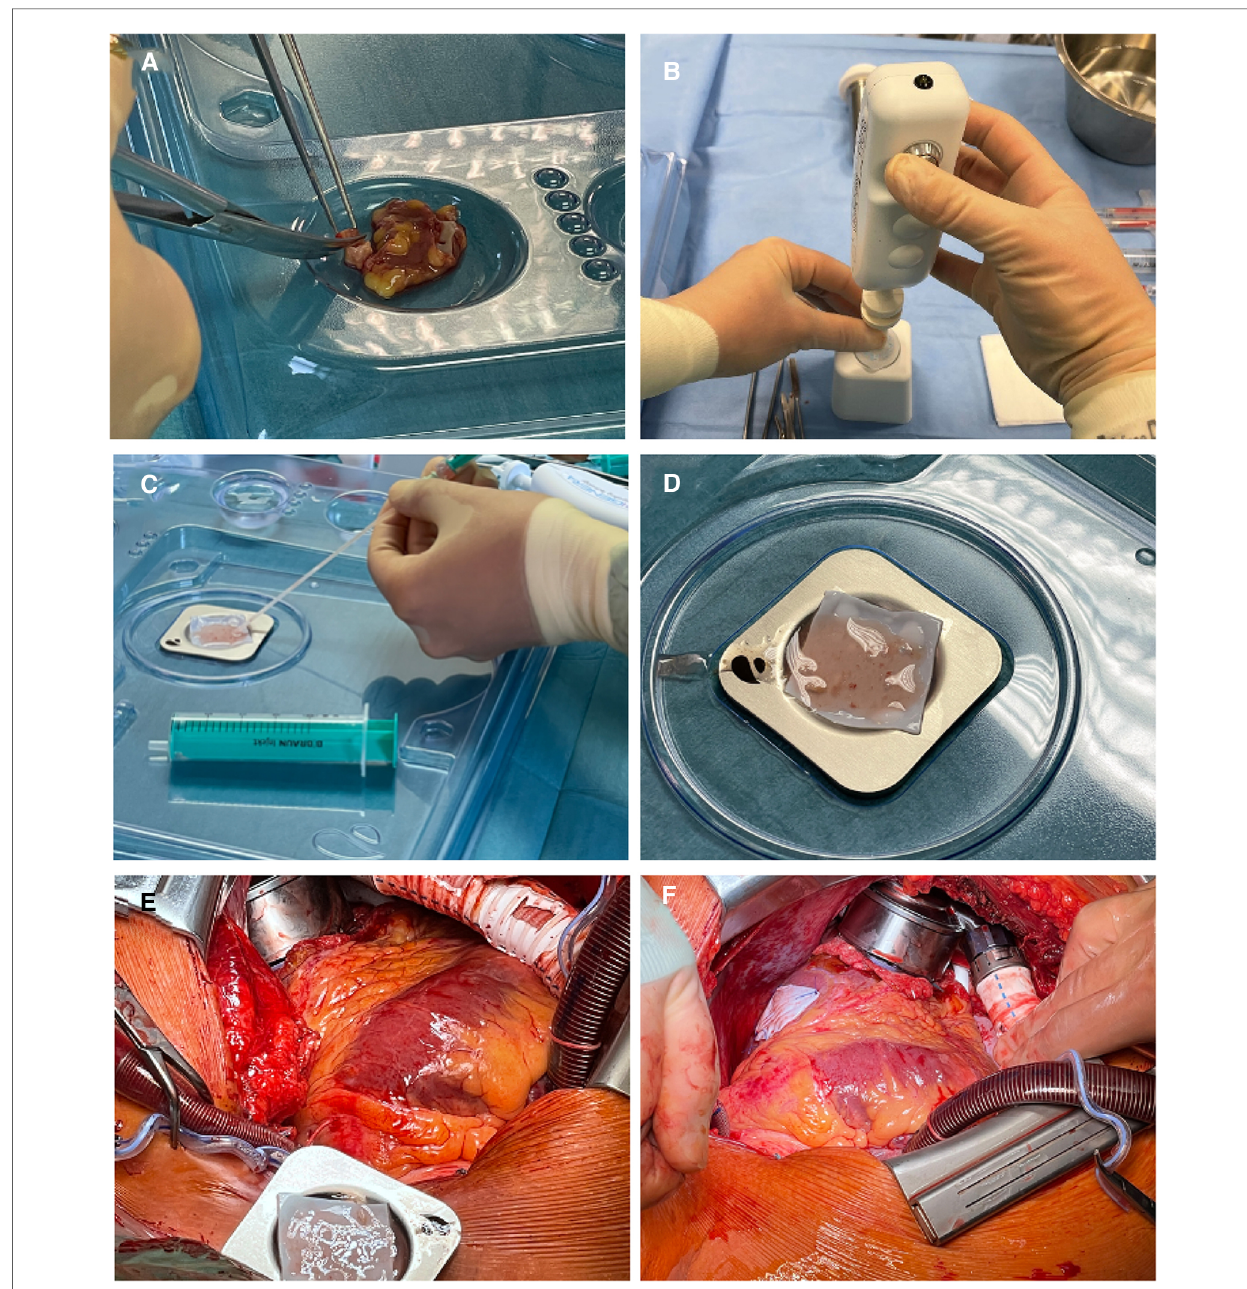
FIGURE 1 Left atrial appendage processing and epicardial transplantation. ( A ) Pieces of LAA are cut for processing. ( B ) Mechanical processing of LAA pieces to micrografts. ( C ) Application of LAA micrografts to the ECM sheet. ( D ) ECM sheet with LAA micrografts waiting for transplantation. ( E ) Transplant in transplant holder for fl ipping onto the epicardial surface. ( F ) Epicardially applied LAA micrograft patch in place on the left ventricle. LAA, left atrial appendage; ECM, extracellular